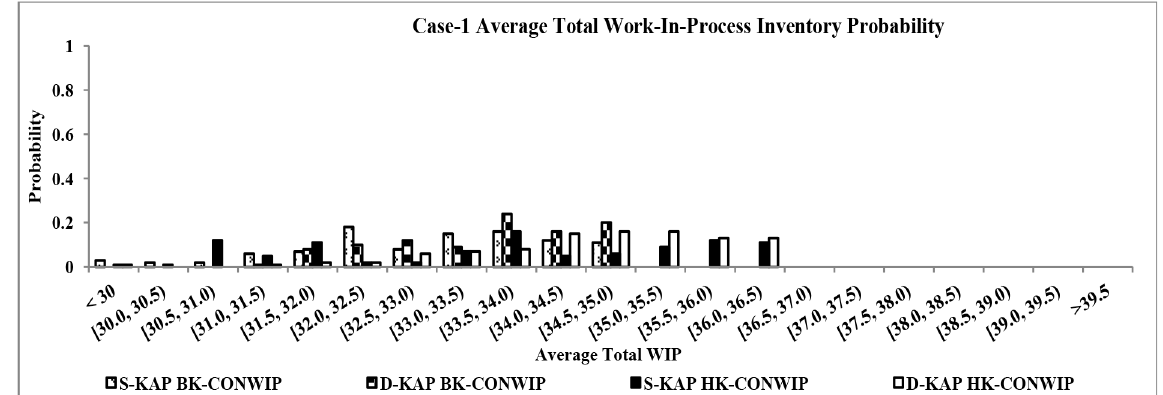
Figure 9. Case-1 average total WIP probability histogram